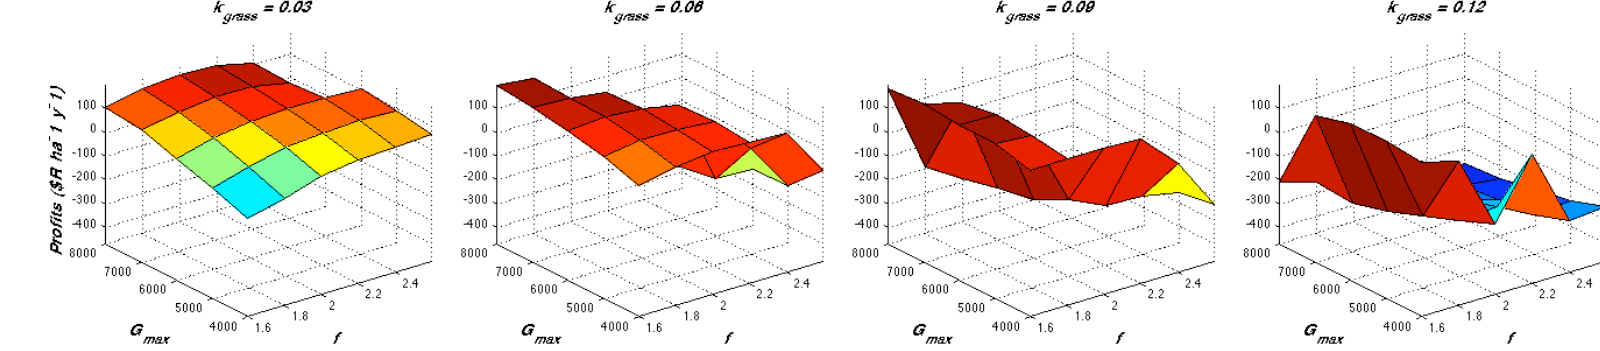
Figure A2.3: Average profits ($R/ha/y) across dimensions of grass capacity G rate k (/t). Individual surfaces show profits as a function of grass capacity and stocking factor f at a constant intrinsic grass growth grass